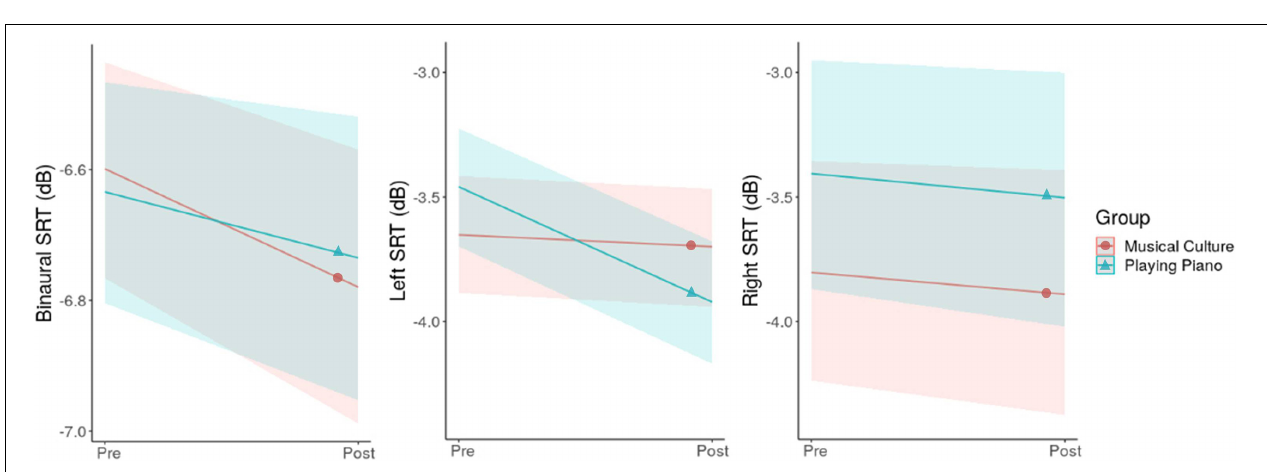
showing a 0.34 dB [0.02, 0.65] higher SRT than women. No Time- by-Group interaction occurred. Both groups improved their SRT by an average of − 0.14 dB ( Figure 1 ,